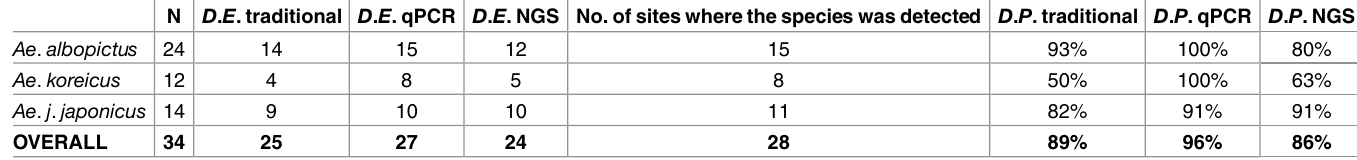
Table 2. Numberof detectionevents (D.E.) and detectionprobabilities (D.P.) withtraditional survey (larvalsampling),qPCR and NGS for the three studiedinvasive mosquitospecies(IMS),in the 34 waterbodieswherethe threemethods have been applied. N: numberof sites